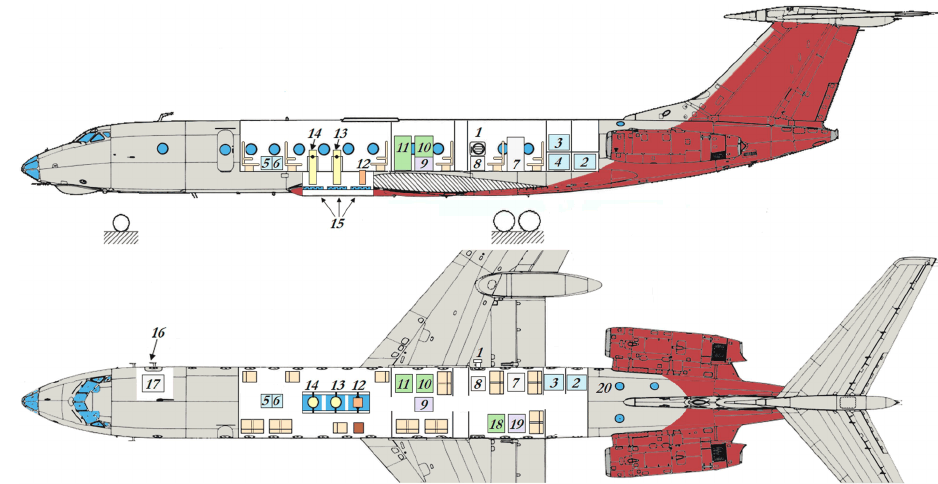
Figure 2. Arrangement of the instrument suite on board the OPTIK TU-134 aircraft laboratory: 1 – ambient air inlets and relative humidity– temperature probe; 2 – aircraft electrical power distribution unit (28V DC); 3, 4, 5, 6 – inverters (28V DC/220V AC) and uninterruptible power supplies (UPSs; Delta RT-2K); 7 – aerosol instrument rack (aethalometer, MDA-02; photoelectric aerosol nephelometer, FAN-M); 8 – aerosol instrument rack (diffusional particle sizer, DPS; optical particle counter, Grimm 1.109; filter; and bioaerosol sampling suite); 9 – navigation system (CompaNav-5.2 IAO); 10 – gas analysis rack (CO 2 –CH 4 –H 2 O; Picarro G2301-m); 11 – gas analysis rack (O 3 , TEI model 49C; CO, TEI model 48C); 12 – spectroradiometer (Spectral Evolution PSR-1100F); 13, 14 – aerosol lidars; 15 – camera hatches; 16 – ambient air inlet; 17 – sampling unit for organic aerosol analysis; 18 – gas analysis rack (NO x ; Thermo Scientific model 42i-TL); 19 – main data acquisition system (NI PXI-1042); 20 – GLONASS/GPS antennas. Figure and caption by Belan et al.